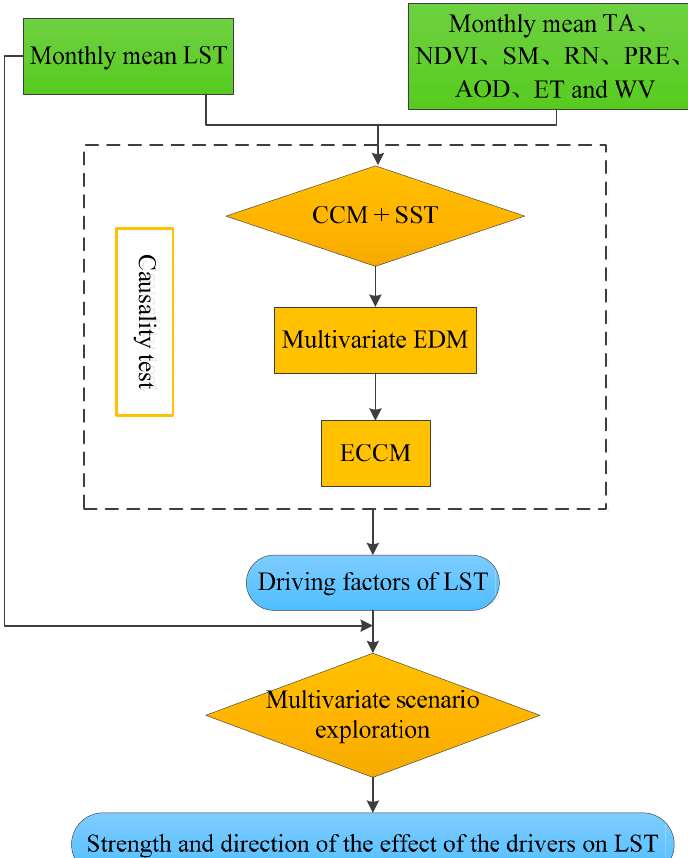
Figure 1. Flowchart of the causality detection between LST and environmental factors.